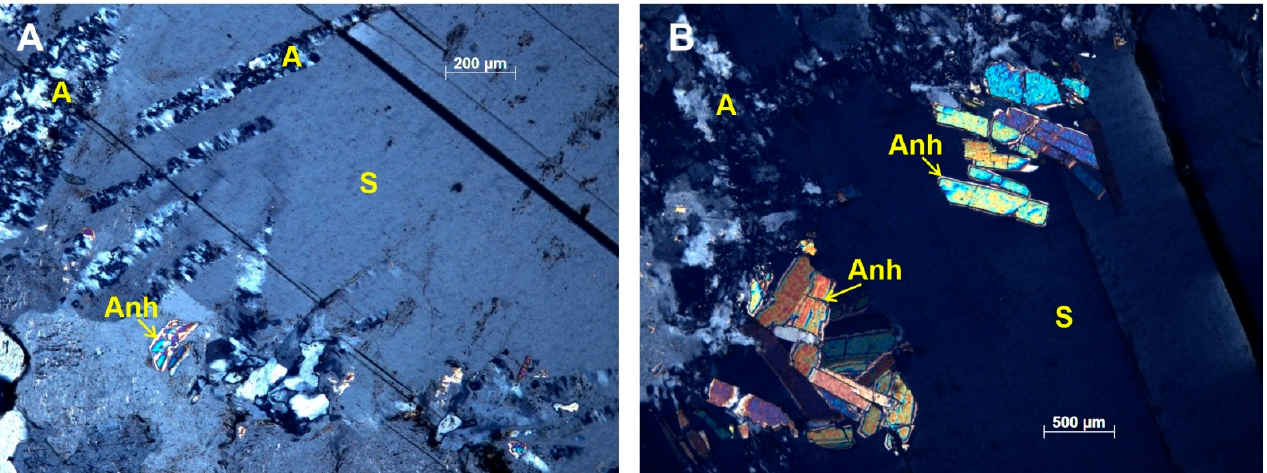
Figure 8. Photomicrographs of gypsum: ( A ) section of a selenite sample in which there has been a limited phase of replacement growth of prismatic anhydrite. Most of these crystals have already been rehydrated to secondary alabastrine gypsum, with local preservation of pseudomorphs. In some of the more elongated and narrower pseudomorphs, a certain pattern perpendicular to the elongation is observed in the gypsum. ( B ) Similar section where more preserved anhydrite crystals of prismatic habit are observed. Legend: S, selenite gypsum; A, alabastrine gypsum; Anh, anhydrite.